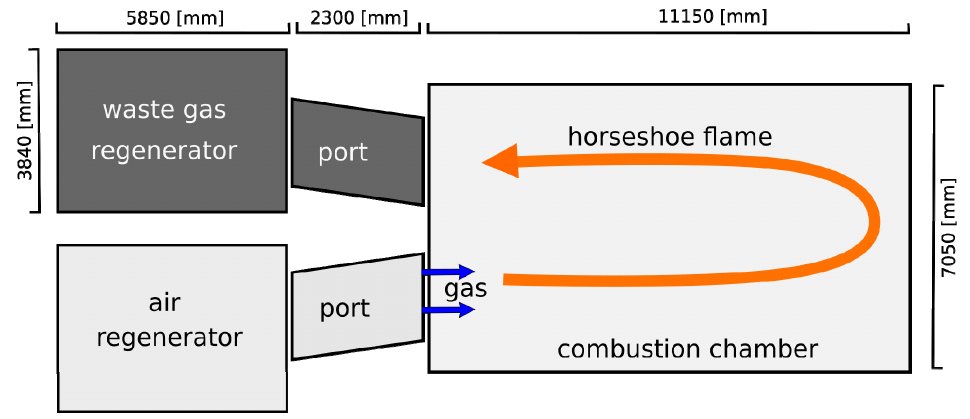
Figure 2. Plant layout of a typical End Port furnace for soda-lime glass production.